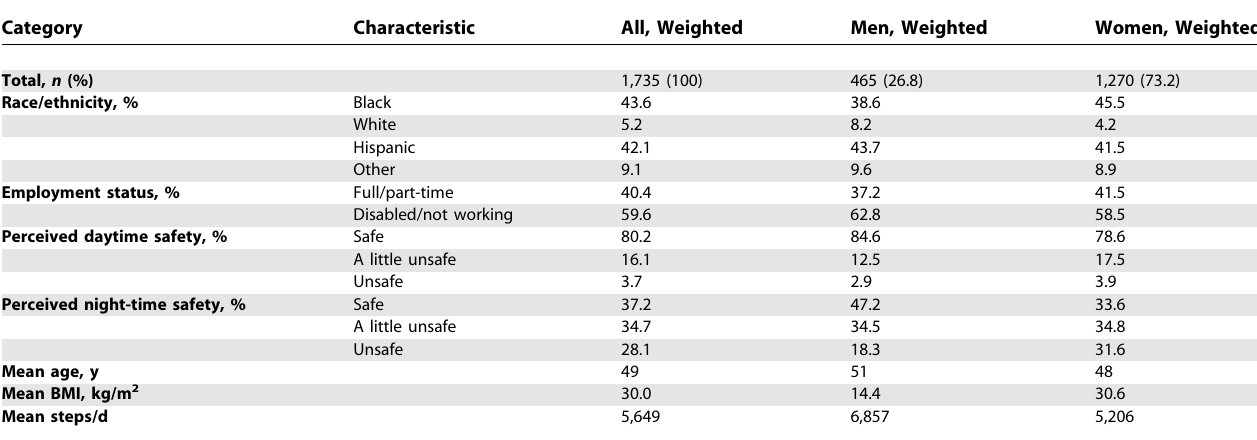
Table 1. Demographic Characteristics of Study Sample Category Characteristic All,